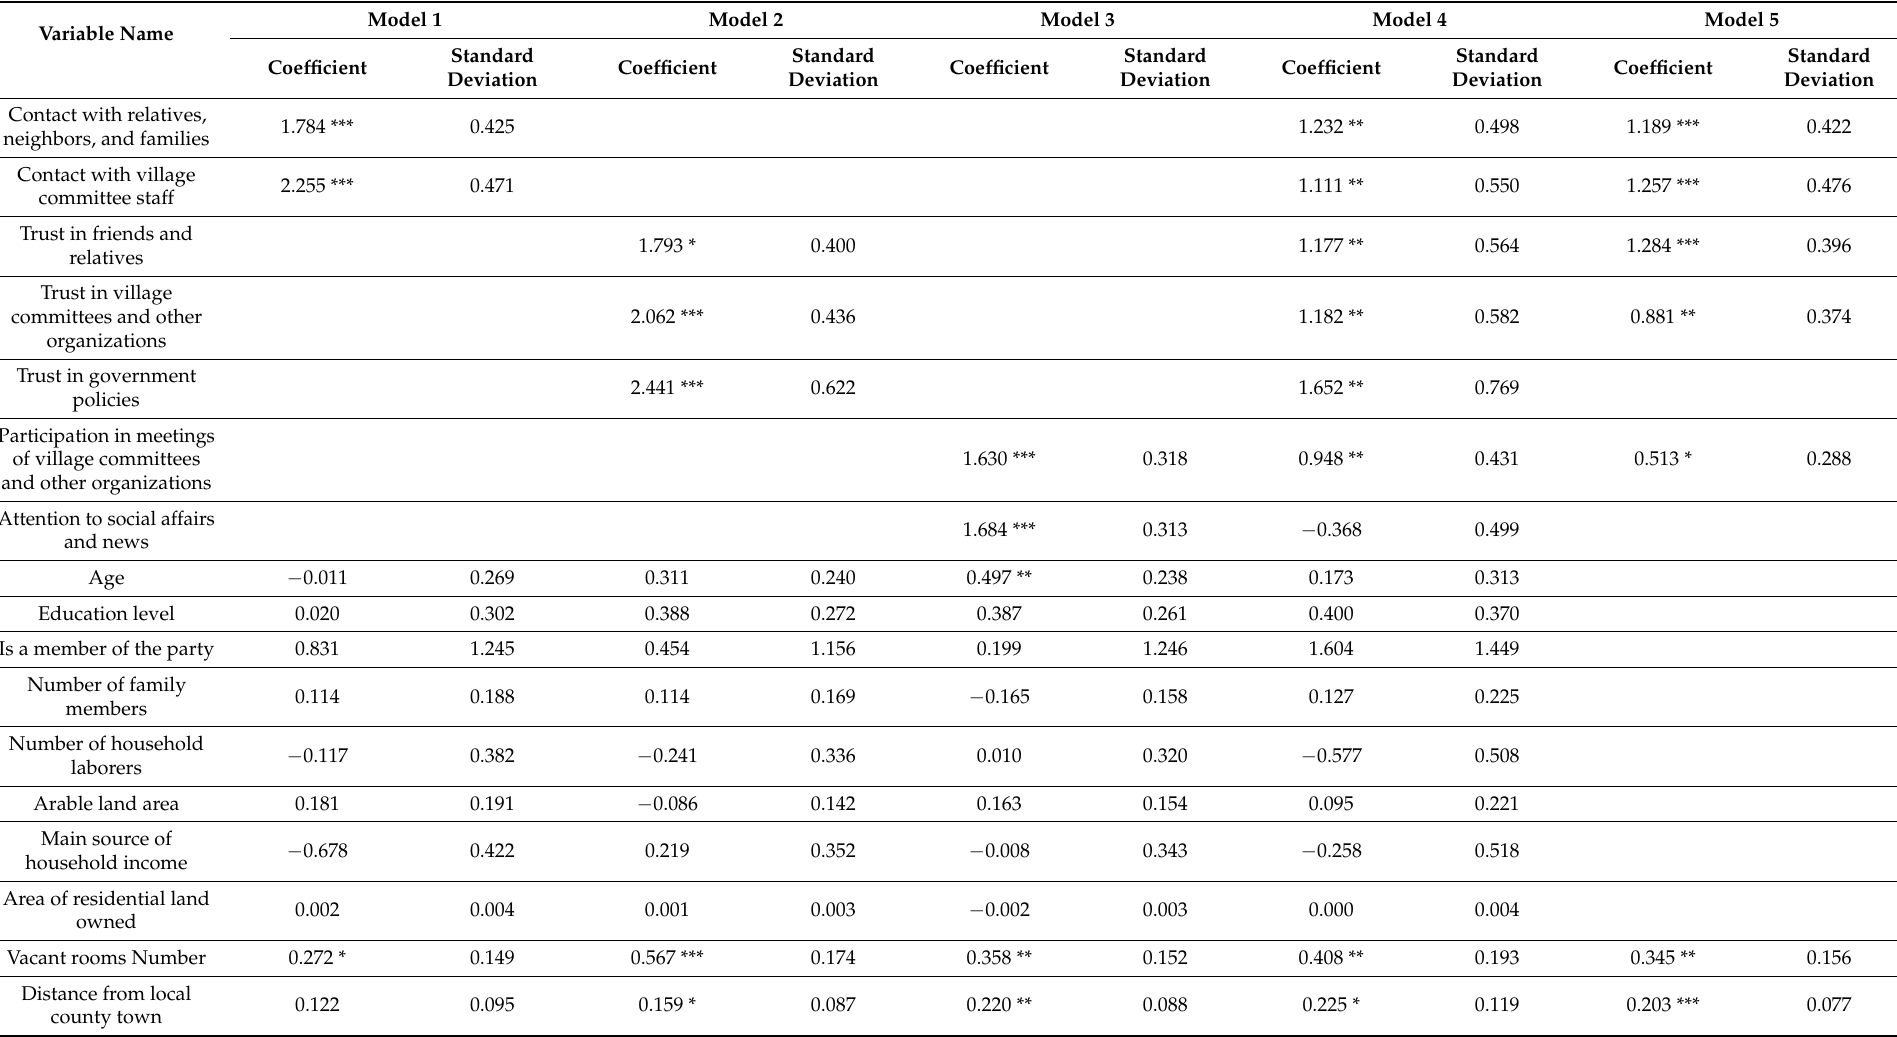
Table 3. Regression results analysis of the effect of social capital on farmers’ willingness to revitalize their